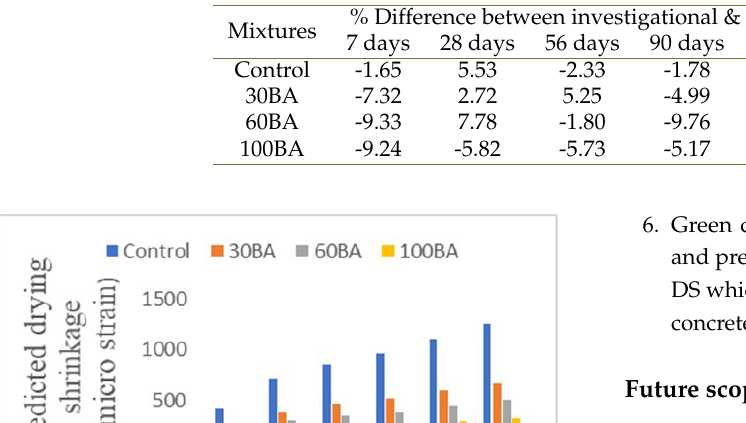
green concrete. Completely transitioning to using green effort to cut